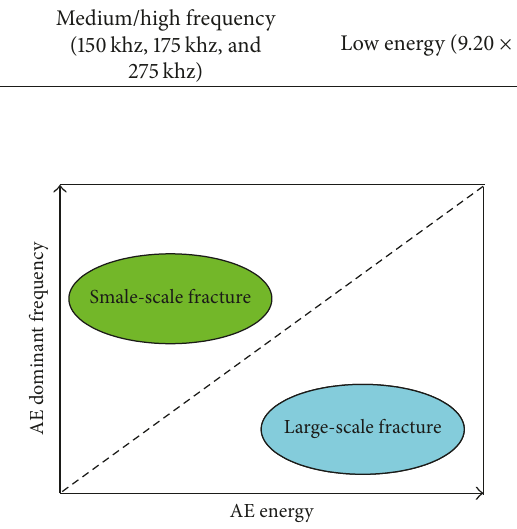
Figure 8: Rupture scale classification